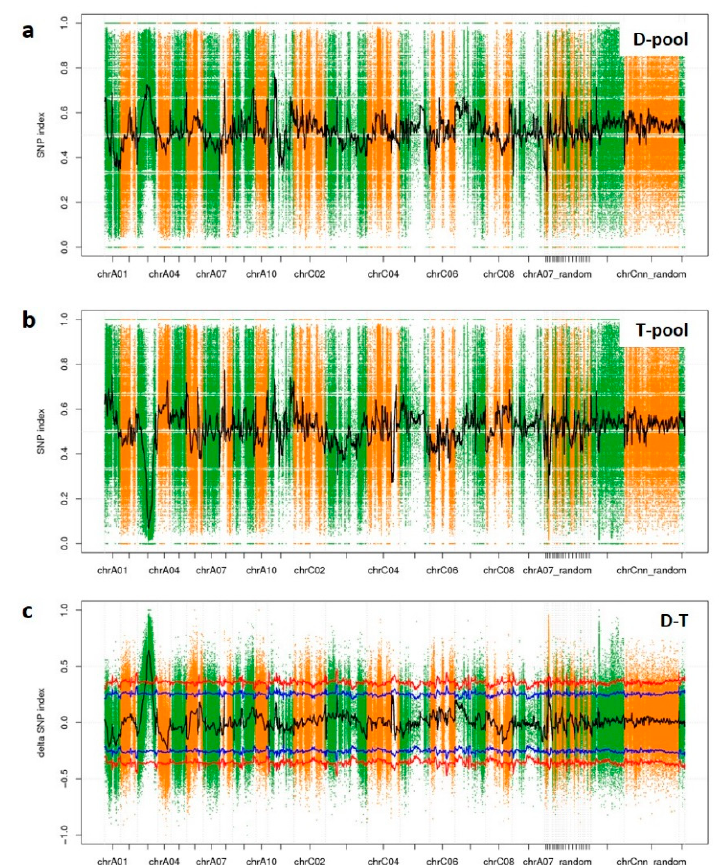
Figure 5. SNP-index of D-pool and T-pool and ∆ (SNP-index) of D-T on chromosomes. ( a ) SNP-index of D-pool; ( b ) SNP-index of T-pool; ( c ) ∆ (SNP-index) of D-T. The peak regions above the threshold values are defined as an associated region. The x axis represents chromosomal position. The y axis shows the SNP-index or ∆ (SNP-index). Blue line: the threshold value line for the 95% confidence intervals ( P value = 5%); red line: the threshold value line for the 99% confidence intervals ( P value = 1%). Table 5. Basic information about the association region on ChrA03.